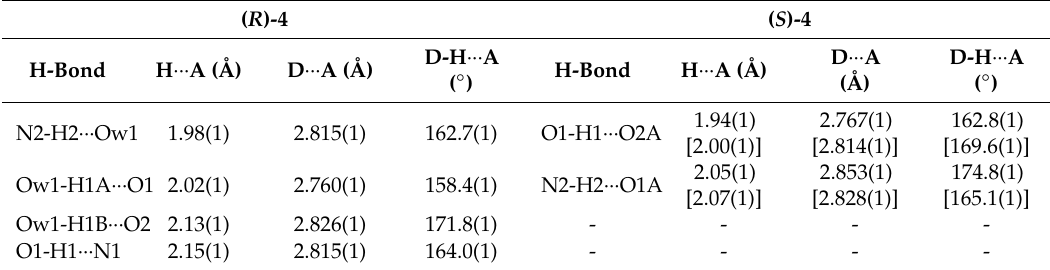
Figure 7. The spacefill representation of the water molecules in ( R )- 4 evidences the presence of water channels in the crystal structure (shown along the c direction). Table 5. Hydrogen-bond geometry of ( R )- 4 and ( S )- 4 (arbitrary atom-numbering scheme used in Figure 4). Values in square brackets refer to the A-labeled molecule in the ASU of ( S )- 4 .